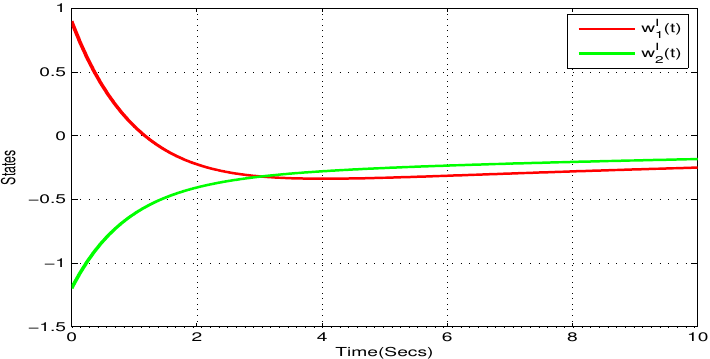
( t ) , w I ( t ) of systems (23) with state feedback control u 2 1